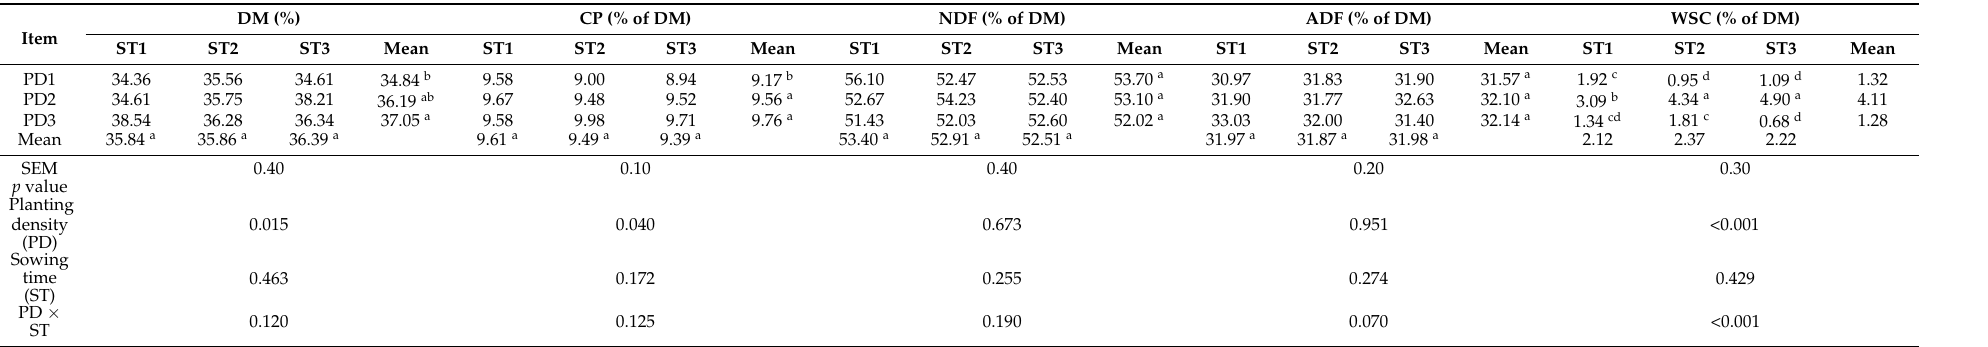
Table 5. Effects of sowing time and planting density of soybean on chemical composition of samples after 60 days of ensiling in corn-soybean strip intercropping